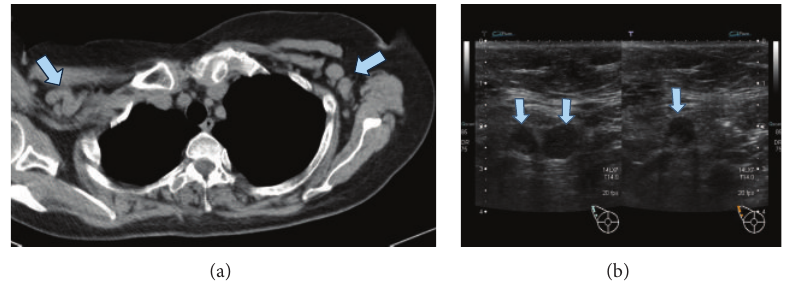
Figure 1: Lymphadenopathy at first admission. Lymphadenopathy was seen in both axial lymph nodes at first admission (a). Malignant lymphoma was suspected because lymph nodes echogram showed elliptical shape and reticular or hypoechoic pattern with deviation of lymph node hilum (b).